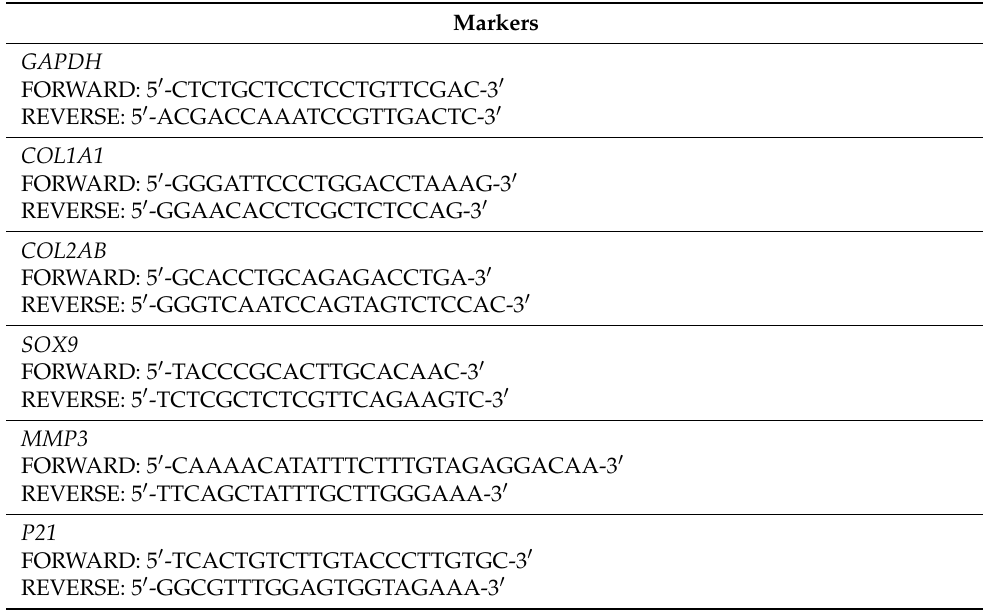
Table 1. Primers used in quantitative real-time polymerase chain reaction.